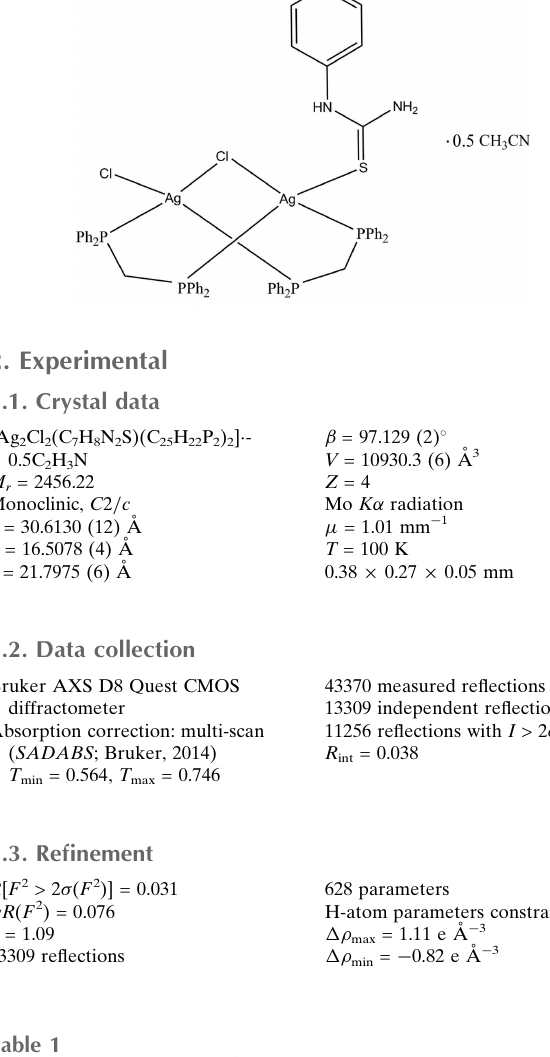
Hydrogen-bond geometry (A˚ , (cid:3)